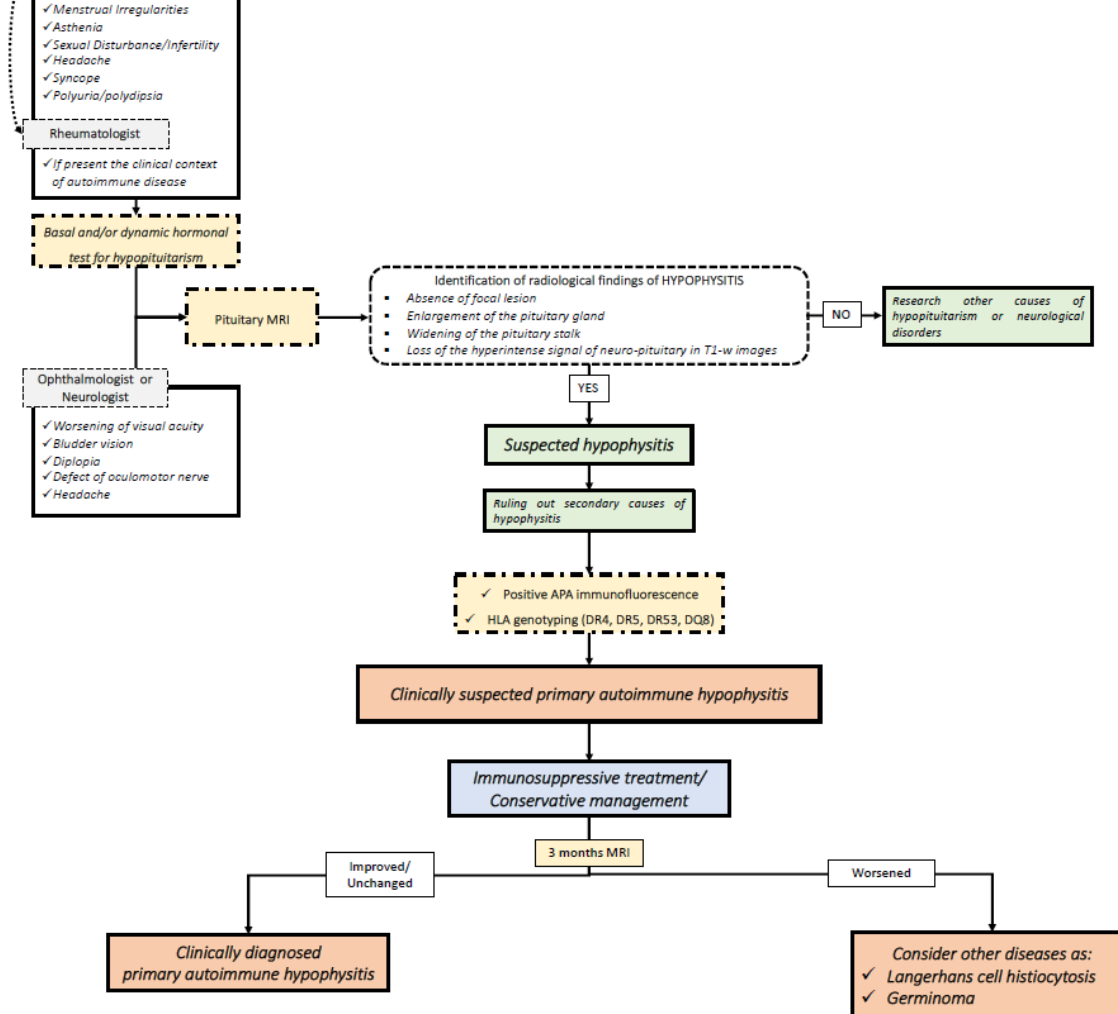
Figure 1. Flow-chart for the diagnosis of primary autoimmune hypophysitis. MRI: magnetic resonance imaging; APA: anti-pituitary antibodies; HLA: human leukocyte antigen.